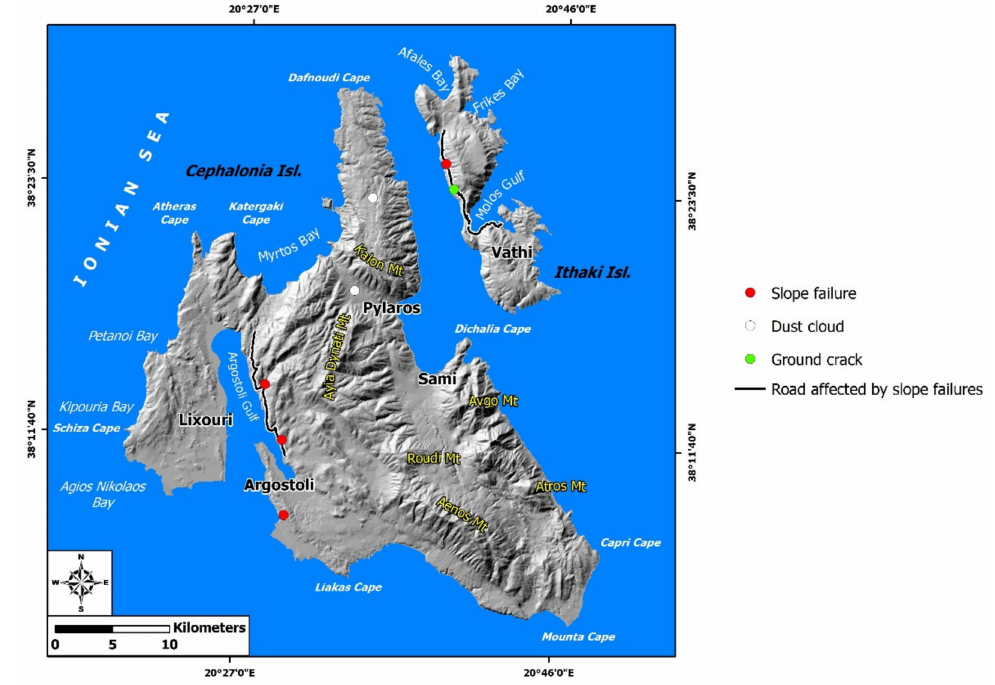
Figure 7. Secondary environmental effects induced by the 9 August 1953 Ionian Sea earthquake in Cephalonia and Ithaki